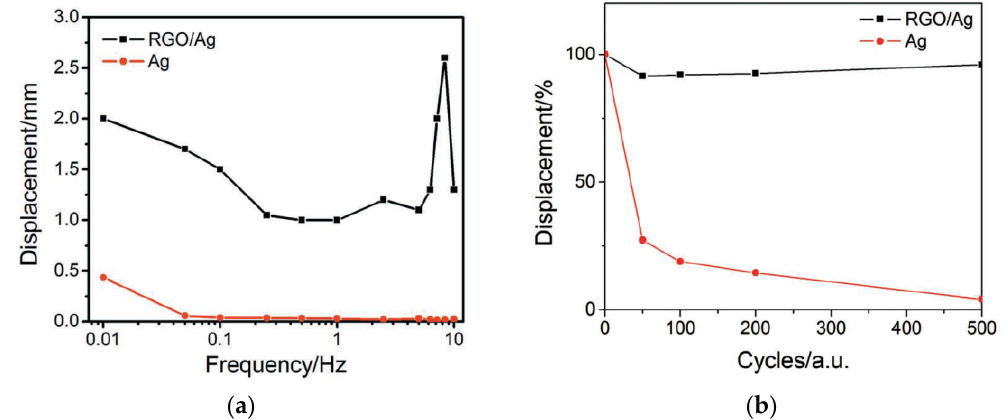
Figure 7. Dependencies of the displacement amplitude of the actuator with combined and pure silver electrodes ( a ) on the frequency and ( b ) on operation time. Reproduced from [31] with permission from John Wiley and Sons. Copyright 2012.